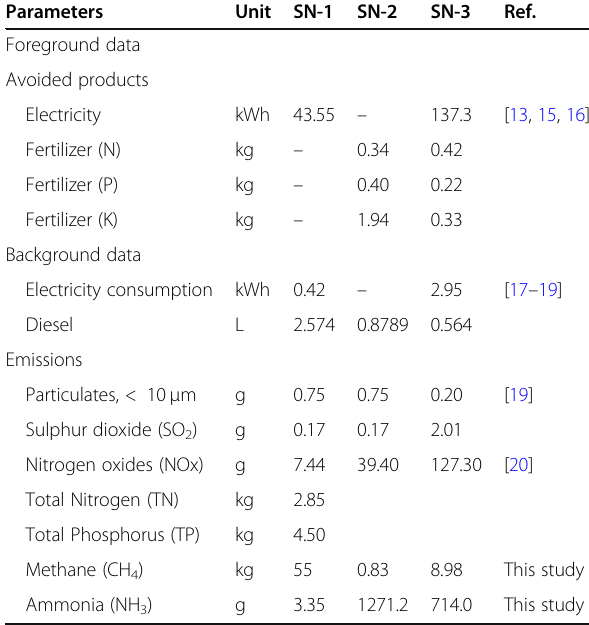
Table 2 Inventory data under each scenario per ton of MSW Parameters